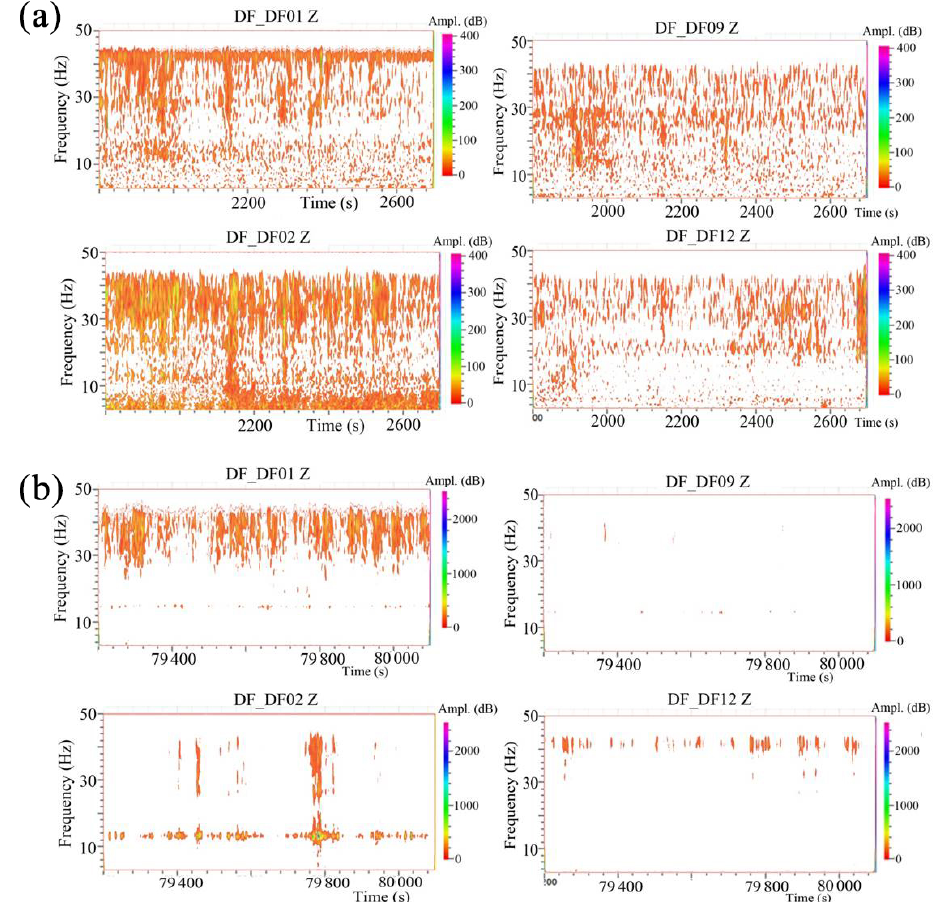
Figure 7. Examples of typical ambient noise spectrograms estimated for the high frequency band (3–50Hz). (a) During the weekend and (b) during the working week.